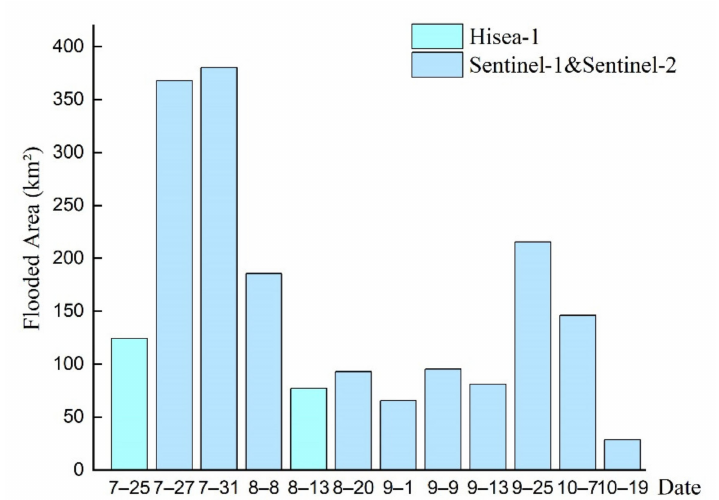
Figure 5. Flooding area statistics based on Sentinel1, Sentinel-2, and Hisea-1 remote sensing data for monitoring the extent of flooding caused by “the 20 July 2021 extraordinary rainfall” event in Henan, China. The figure was plotted by Origin2022